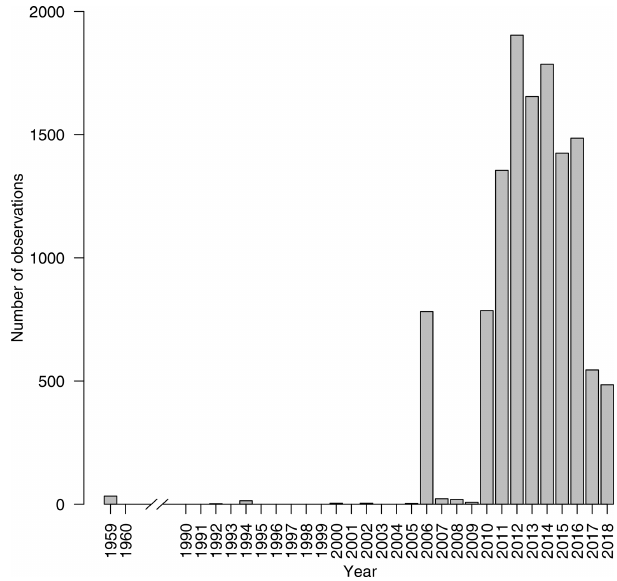
Figure 2. Temporal distribution of the samples included in